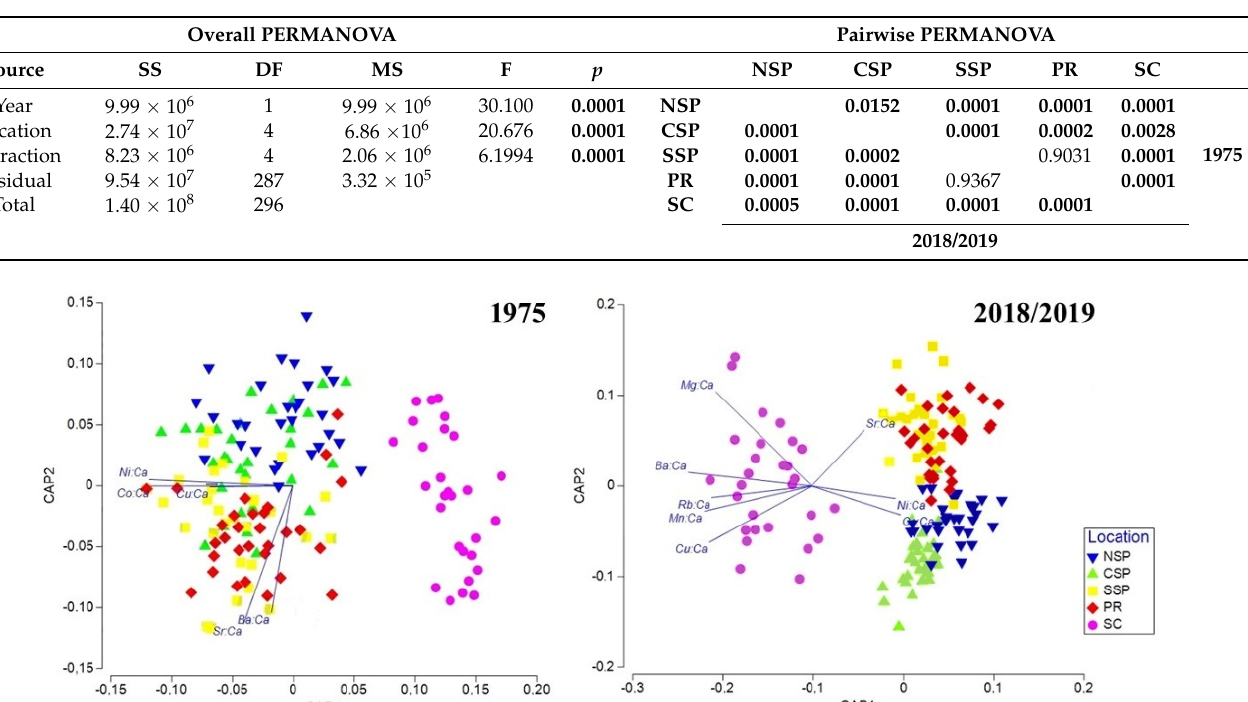
success of 58%, highlighting the SC samples that were all fully reallocated to the original location (100%) and the NSP samples that reached 70% of correct reclassification, contrary Table 3. Overall and pairwise PERMANOVA comparisons among the five sampling locations regarding the chemical composition of Isopisthus parvipinnis otoliths collected in 1975 and 2018/2019. Significant statistical differences ( p < 0.05) were marked in bold. Legend: North of S ã o Paulo (NSP),